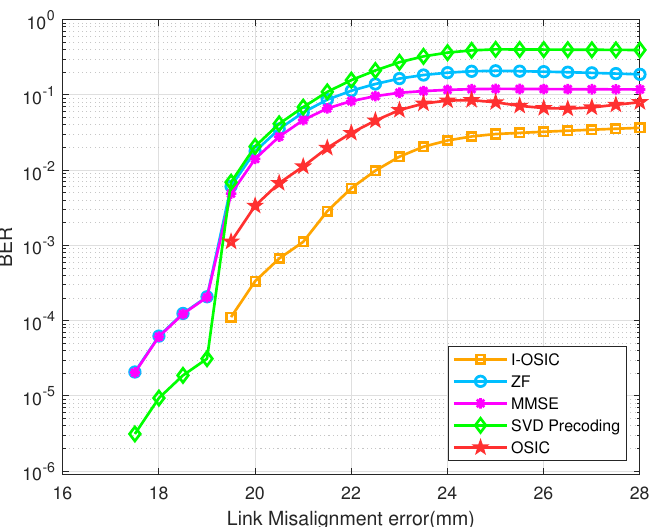
Figure 13. The system BER versus the link misalignment error when SNR is 30